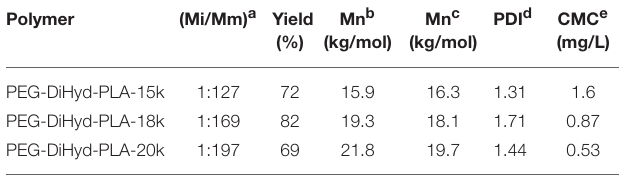
TABLE 1 | Synthesis of triblock polymers PEG-DiHyd-PLA.